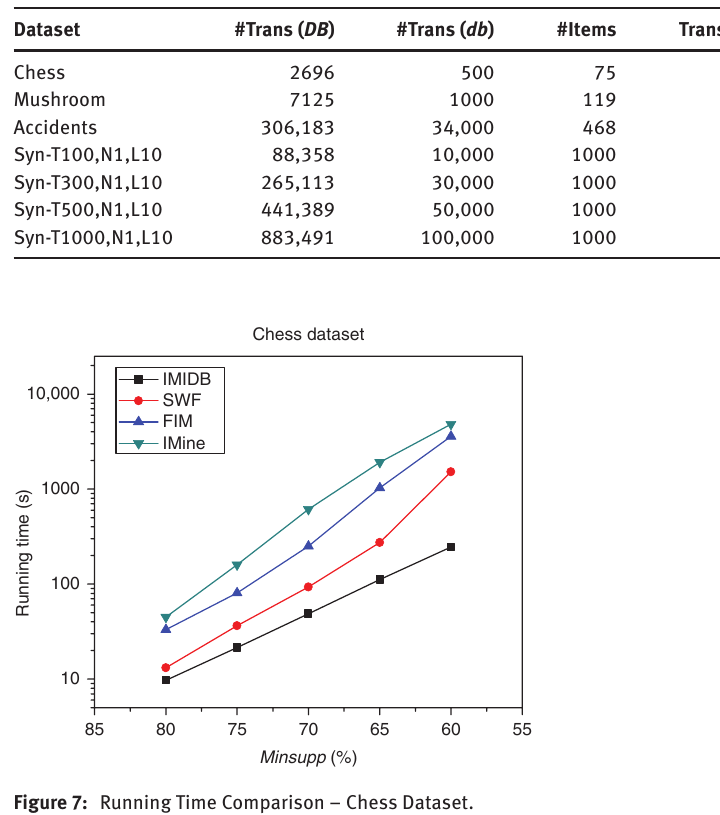
Table 11: Database Information [9].